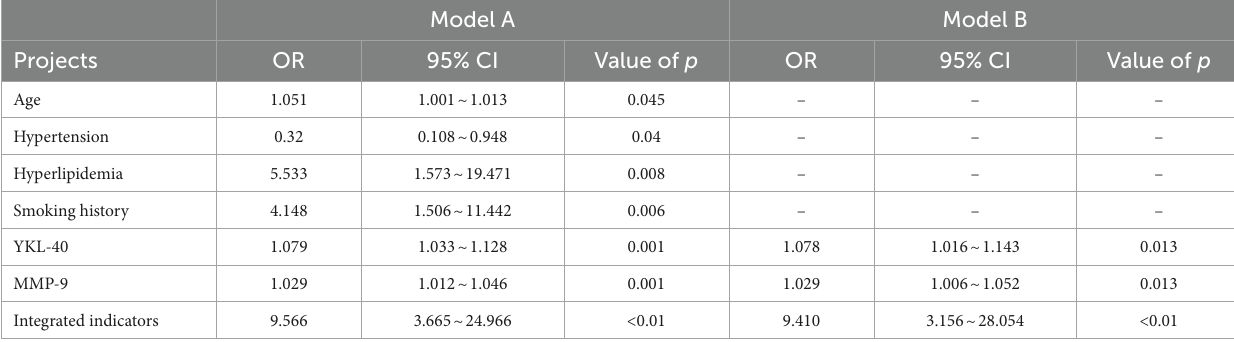
TABLE 2 Binary logistic regression analysis of risk factors for positive